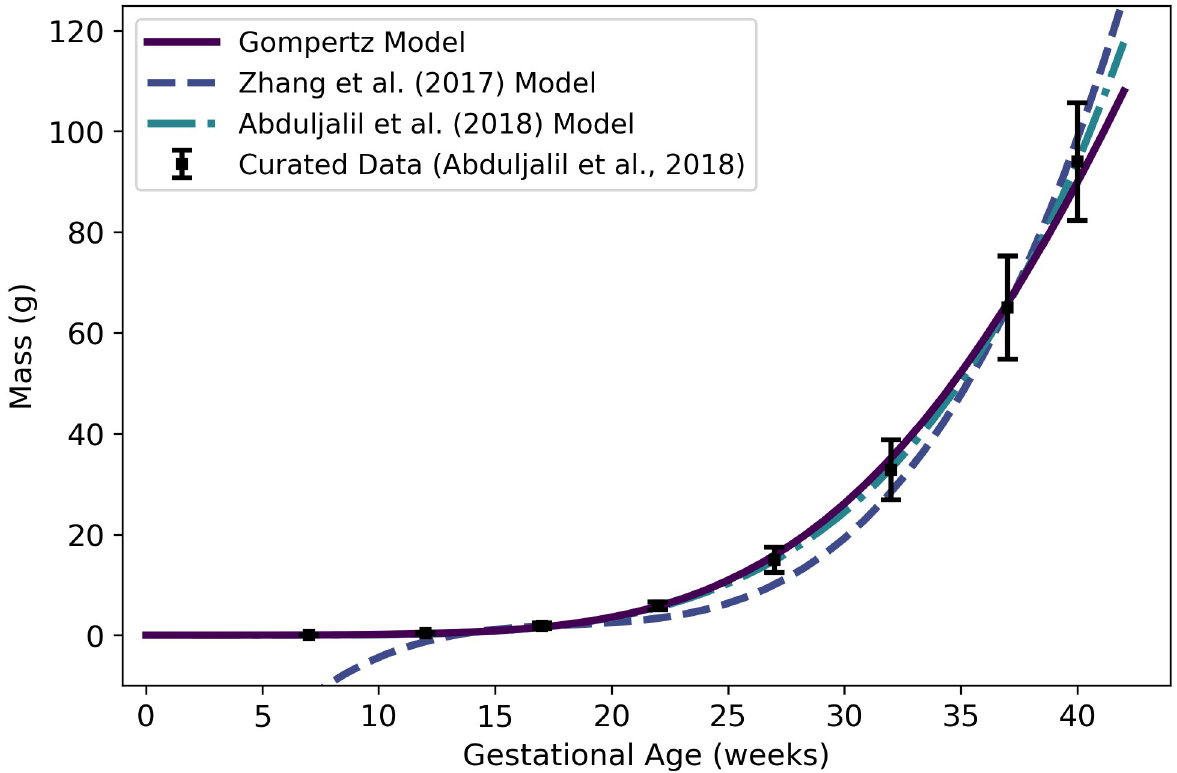
Fig 20. Fetal gut mass vs. gestational age. The Gompertz model (solid line) given by Eq 41 was selected as the most parsimonious model in our analysis. The model of Zhang et al. [32] was calibrated using a different data set. The Zhang et al. [32] model describes gut volume, so the units were converted assuming a tissue density of 1